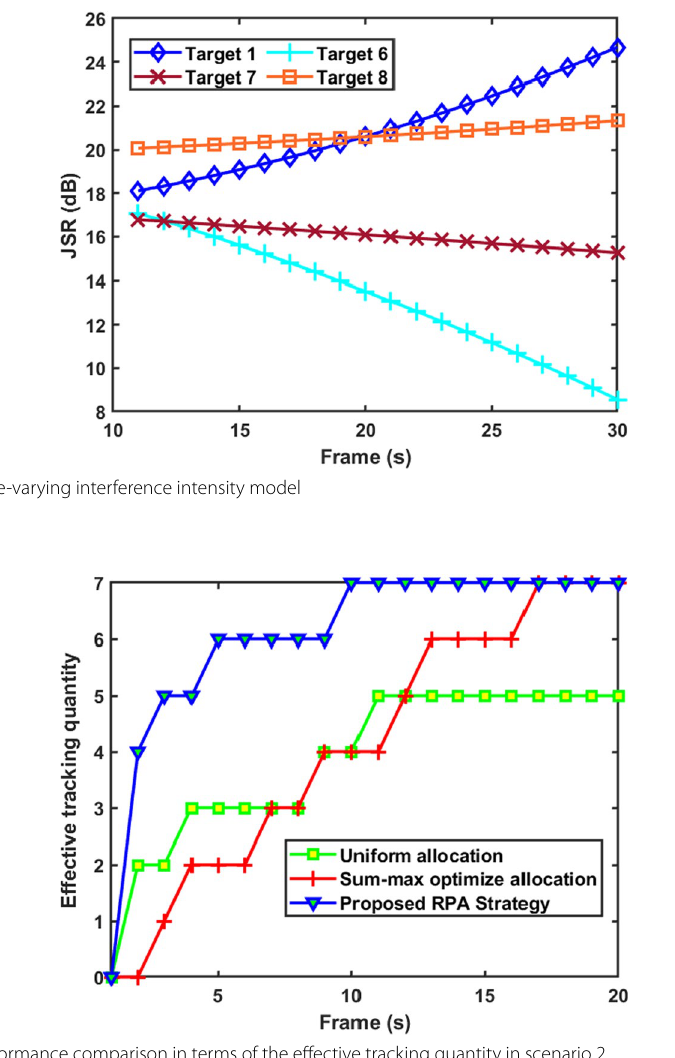
Fig. 7 Performance comparison in terms of the effective tracking quantity in scenario